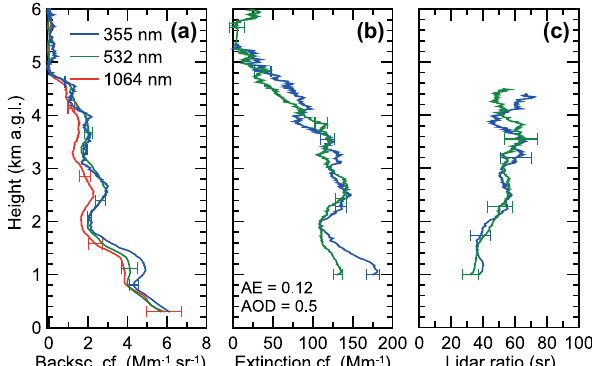
Figure 4. 45min mean profiles of (a) the particle backscatter coef- ficient at three wavelengths, (b) extinction coefficient at two wave- lengths, and (c) extinction-to-backscatter ratio (lidar ratio) at two wavelengths, measured with BERTHA on 11 July 2013, 00:00– 00:45UTC. Error bars indicate the retrieval uncertainty (1 stan- dard deviation). The vertical signal smoothing window length is 200m (backscatter coefficient) and 1000m (extinction coefficient, lidar ratio). The column values of the Ångström exponent (AE 440–870nm) and the aerosol optical depth (AOD) from the clos- est AERONET observation are